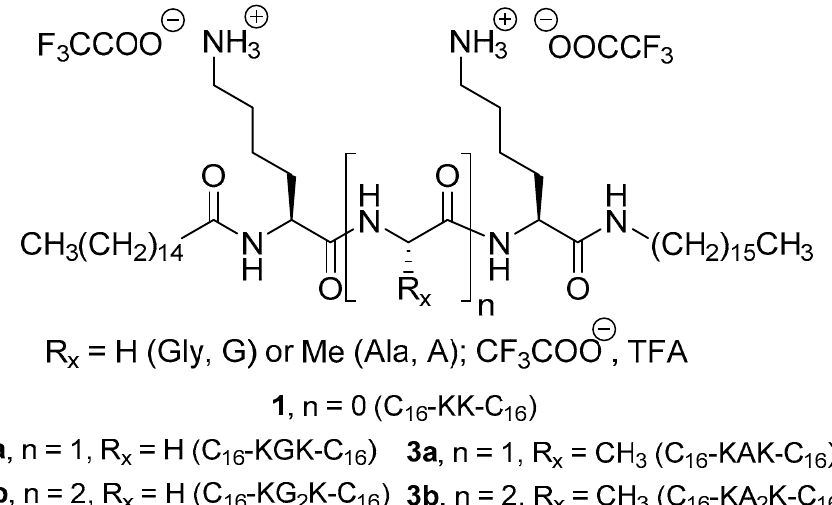
Figure 1. Geminoid structures.